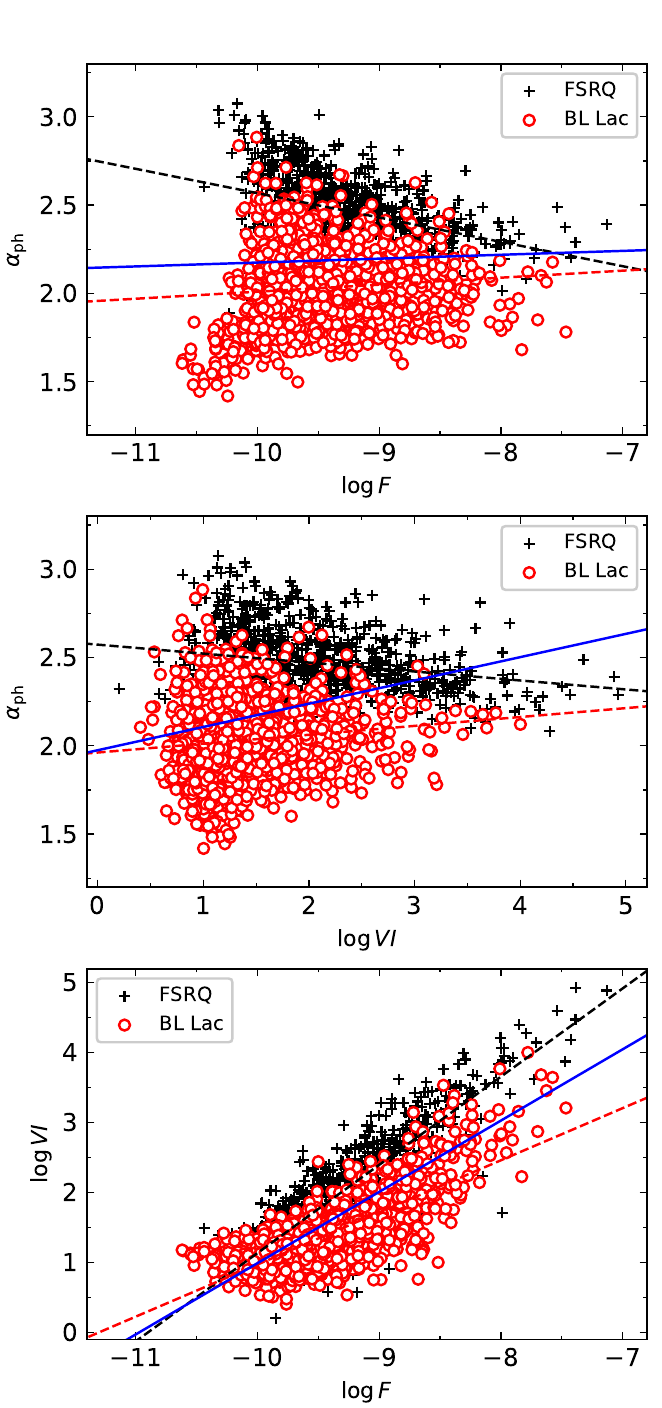
Figure 2. Plot of mutual correlations. The symbol ‘plus’ is for FSRQs, and the ‘open circle’ is for BL Lacs. The straight blue line stands for the best fitting result for blazars (BL Lacs and FSRQs), the ‘broken black line’ for FSRQs and the ‘broken red line’ for BL Lacs. The upper panel is for the plot of photon spectral index ( α ph ) versus γ -ray photon flux (log F (photon/cm 2 /s)); middle panel for photon spectral index ( α ph ) against variability index (log VI ) and lower panel for variability index (log VI ) against γ -ray photon flux (log F (photon/cm 2